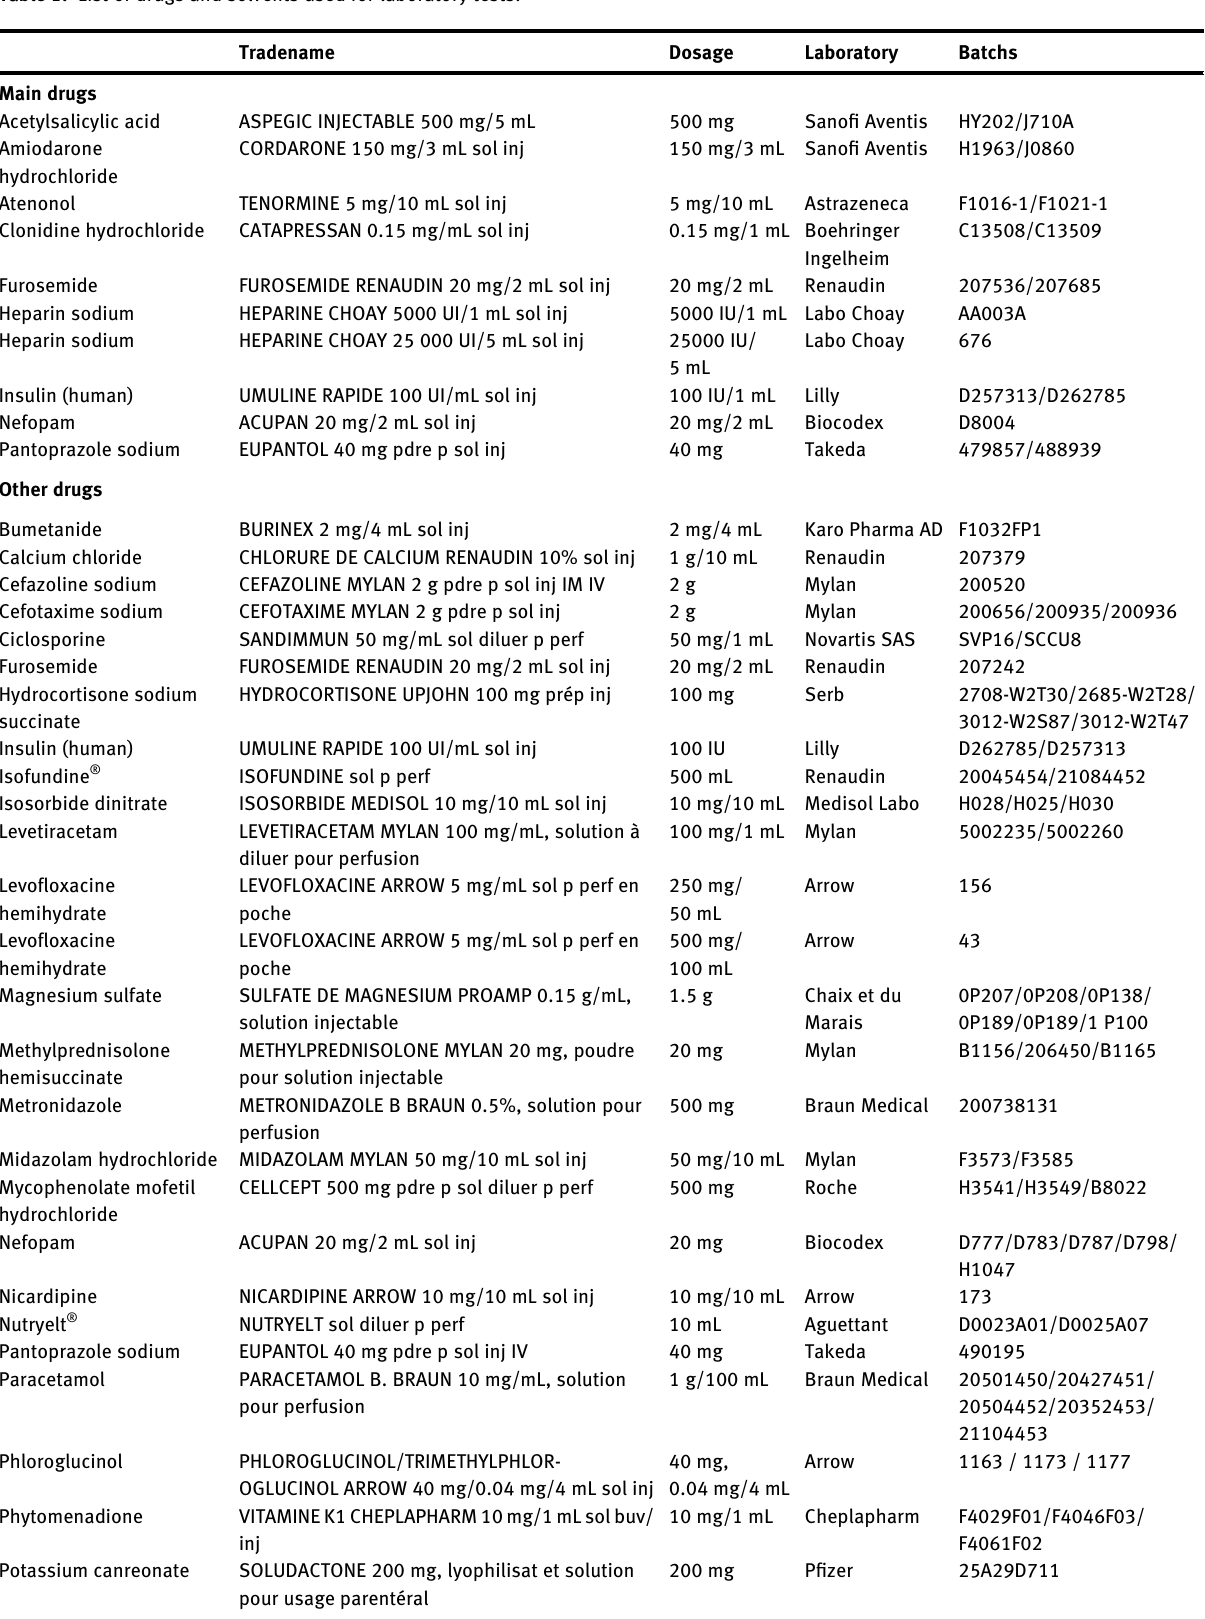
Table  : List of drugs and solvents used for laboratory tests. Tradename Dosage Laboratory